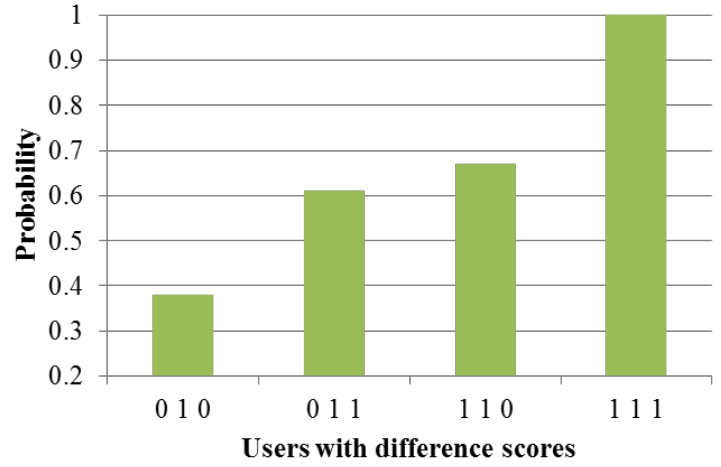
Figure 11. Search results when α = 0.1, β = 0.8, and γ = 0.1.